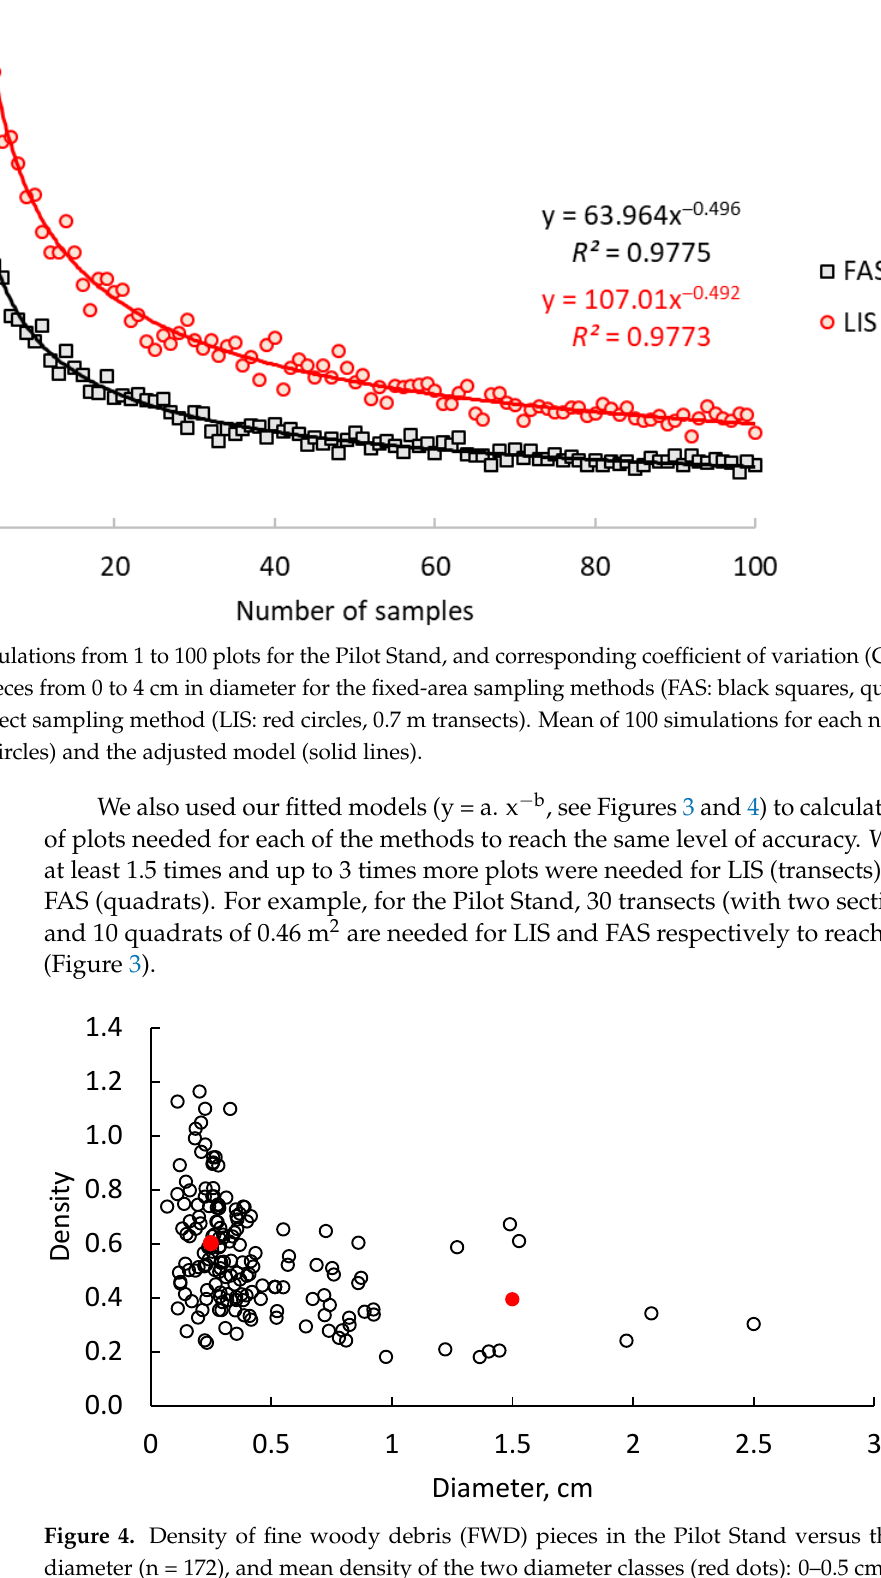
Figure 2 . Sampling simulations from 1 to 100 plots for the Test Zone, and the corresponding coefficient of variation (CV) of the estimated volume for pieces from 0 to 4 cm in diameter for the fixed-area sampling methods (FAS: black squares, quadrats of 0.46 m 2 ) and line-intersect sampling method (LIS: red circles, 0.7 m transects). Mean of 100 simulations for each number of samples (squares and circles) and the fitted model (solid lines).